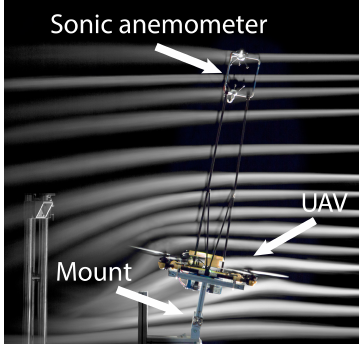
Figure 9. Setup of the wind tunnel measurement. The UAV is at- tached to a mount at multiple suitable pitch angles (here 10 ◦ ) rep- resenting forward flight. Wind speed measurements (here 9ms − 1 ) with running motors were compared to measurements with stopped motors. This “tethered” setup was also compared to free flights in the wind tunnel. Smoke trails were used for illustration pur- poses. A video of the wind tunnel testing is available at https: //youtu.be/wWPY3eVxUkU (last access: 9 February